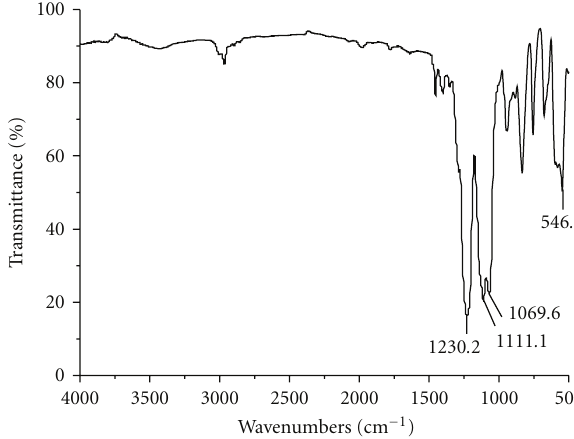
Figure 2: FT-IR spectra of fire-retardant agent 1b